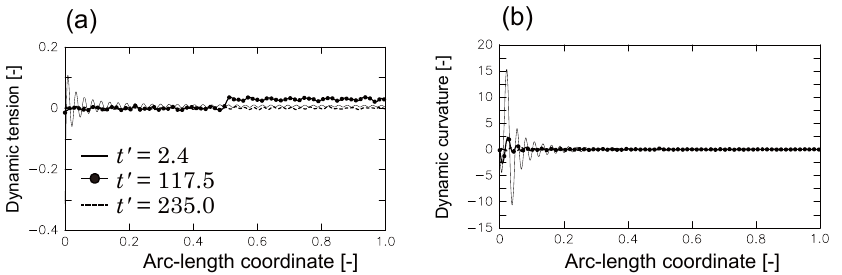
Figure 7. Distributions of the ( a ) tangential and ( b ) normal displacements for one bucket. t (cid:48) denotes dimensionless time.